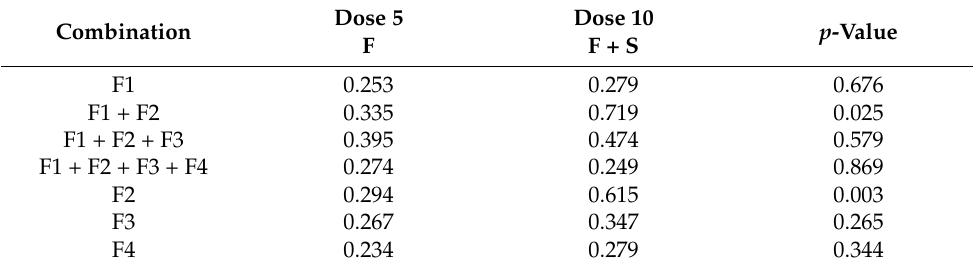
Table 6. Selenium content in wheat grain depending on fertilisation